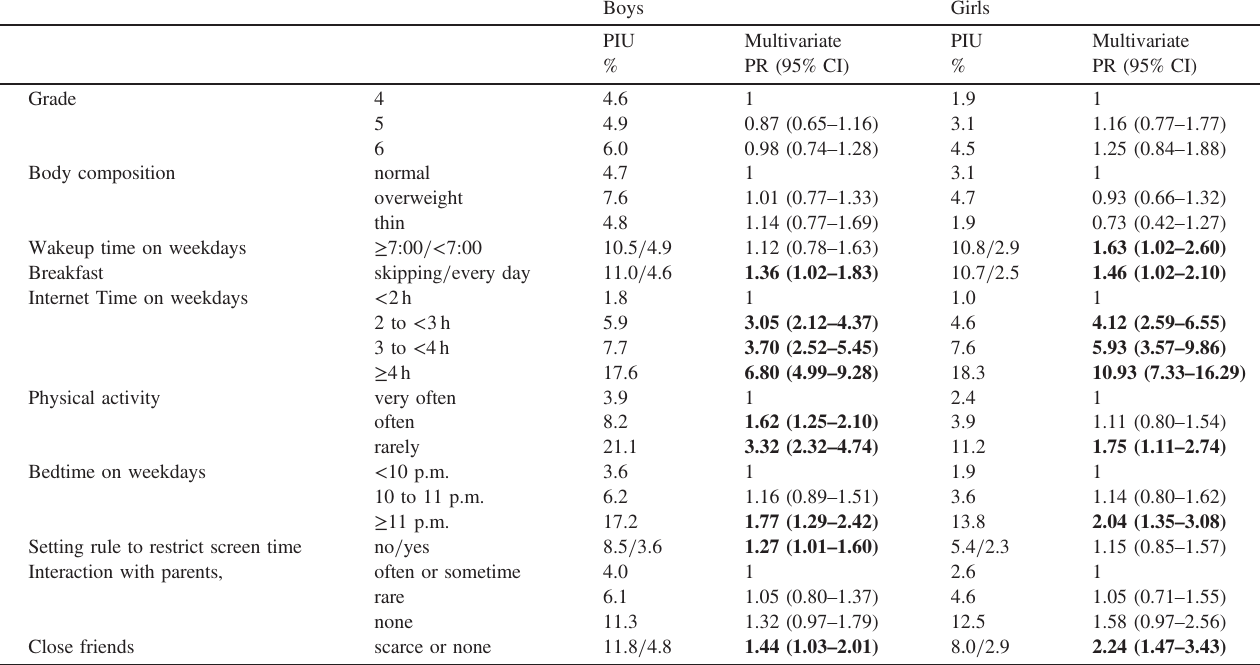
Table 3. Poisson regression analyses on pathological Internet use by sex, n =